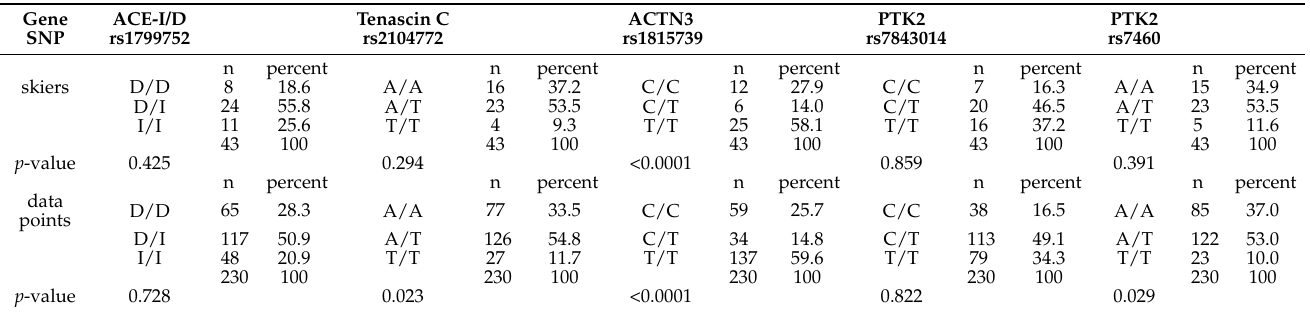
Table 1. Characteristics of the athletes. Summary of the genotypes of the studied alpine and nordic skiers from the Swiss skiing squad